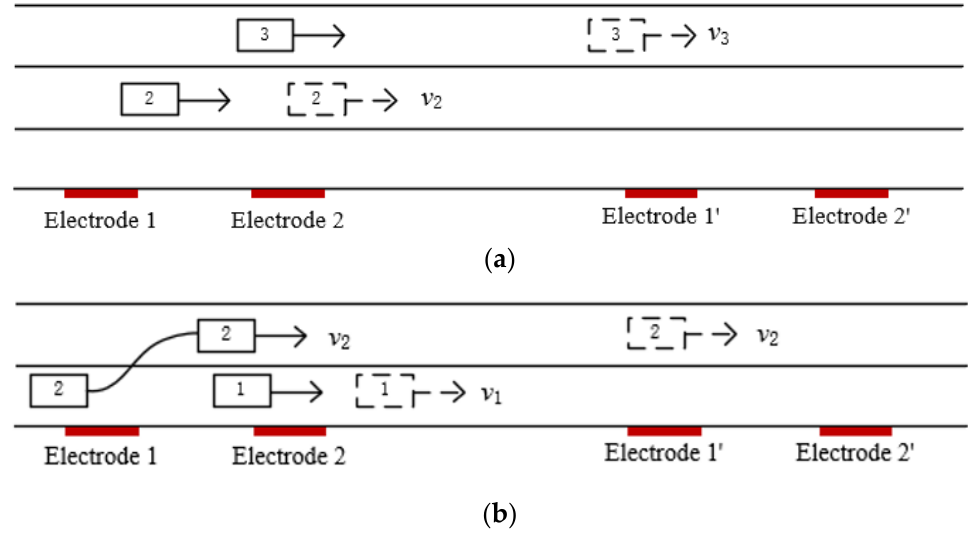
Figure 17. Diagram of two groups of electrodes for two scenarios: ( a ) two vehicles driving in different lanes; ( b ) changing lanes and